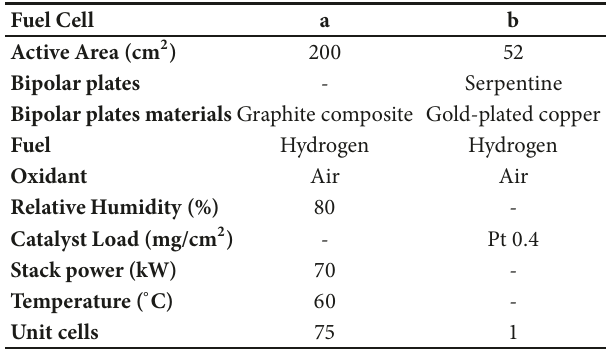
Table 4: Construction and operational parameters of fuel cells presented in Figure